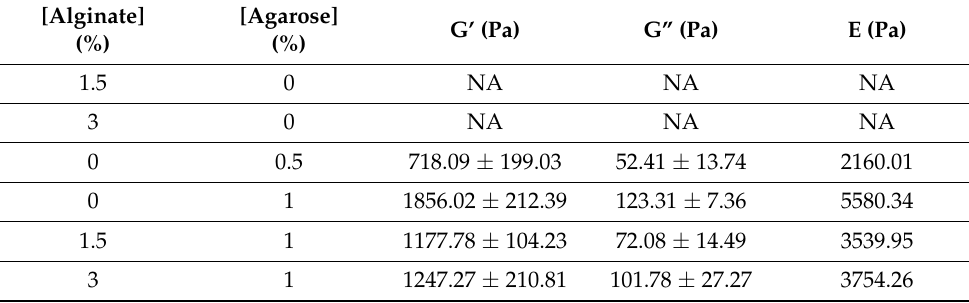
Table 2. Mechanical testing of alginate-agarose hydrogels for a torque of 50 µ